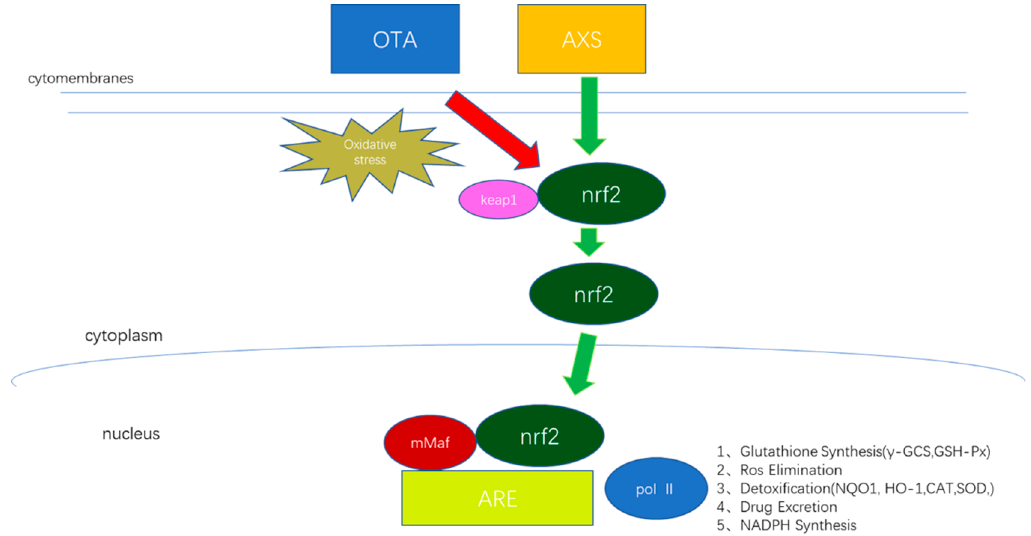
Figure 8. The flow diagram of the NRF2 / KEAP1 signal pathway. Under physiological conditions, Nrf2 is negatively regulated and ubiquitinated though Keap1. When oxidative stress occurs, the interaction between Nrf2 and Keap1 is destroyed, Nrf2 of free type accumulates in the cytoplasm, Nrf2 translocations to the nucleus were increased, and this activates downstream antioxidant protein to resist oxidative stress.